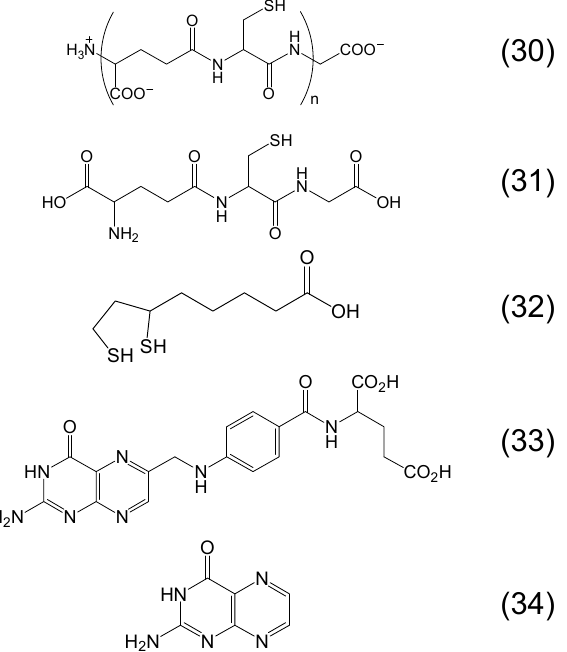
Figure 9. Examples of phytochelators containing a thiol and pterin in the metal binding site. Phytochelatin ( n = 2–11) ( 30 ), glutathione or (2 S )-2-amino-5-[[(2 R )-1-(carboxymethylamino)-1-oxo-3- sulfanylpropan-2-yl]amino]-5-oxopentanoic acid ( 31 ), dihydrolipoic acid (6,8-dimercapto-octanoic acid) ( 32 ), folic acid or (2 S )-2-[[4-[(2-amino-4-oxo-1 H -pteridin-6-yl)methylamino]benzoyl]-amino]pentanedioic acid ( 33 ) and pterin or 2-amino-1 H -pteridin-4-one ( 34 ).